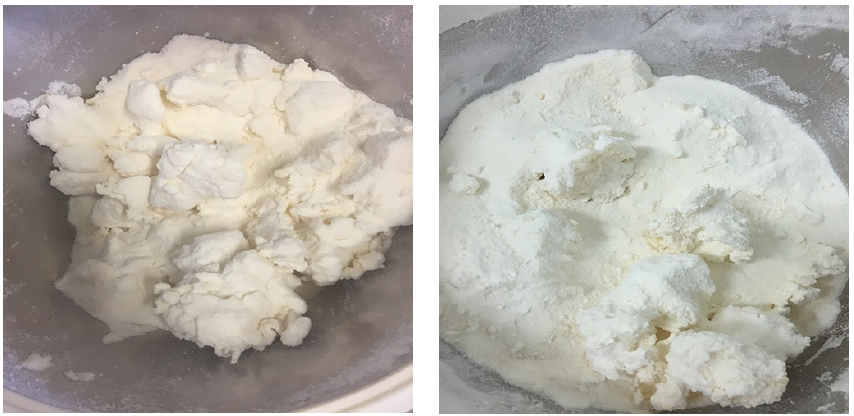
Figure 3. The resultant agglomerated powder in treatments that had the combination of 140 g pre-wet mass and 5.6 mL · min − 1 flow rate. The resultant powder did not meet the industrial specification of WPI.